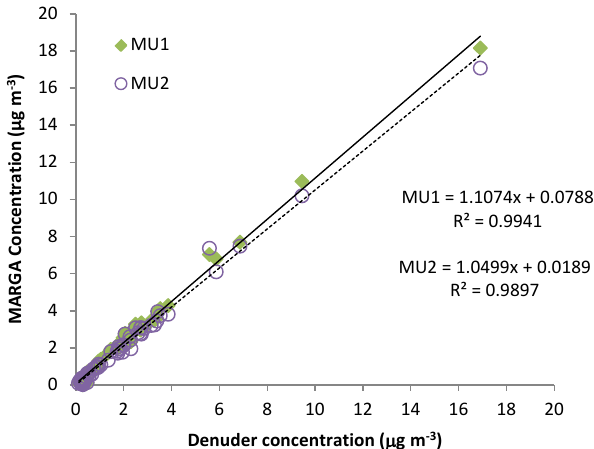
Figure 5. Regression analysis of MARGA SO 2 concentrations Fig. 5. Regression analysis of MARGA SO 2 concentrations against denuder SO 2 concentrations. 2 against denuder SO 2